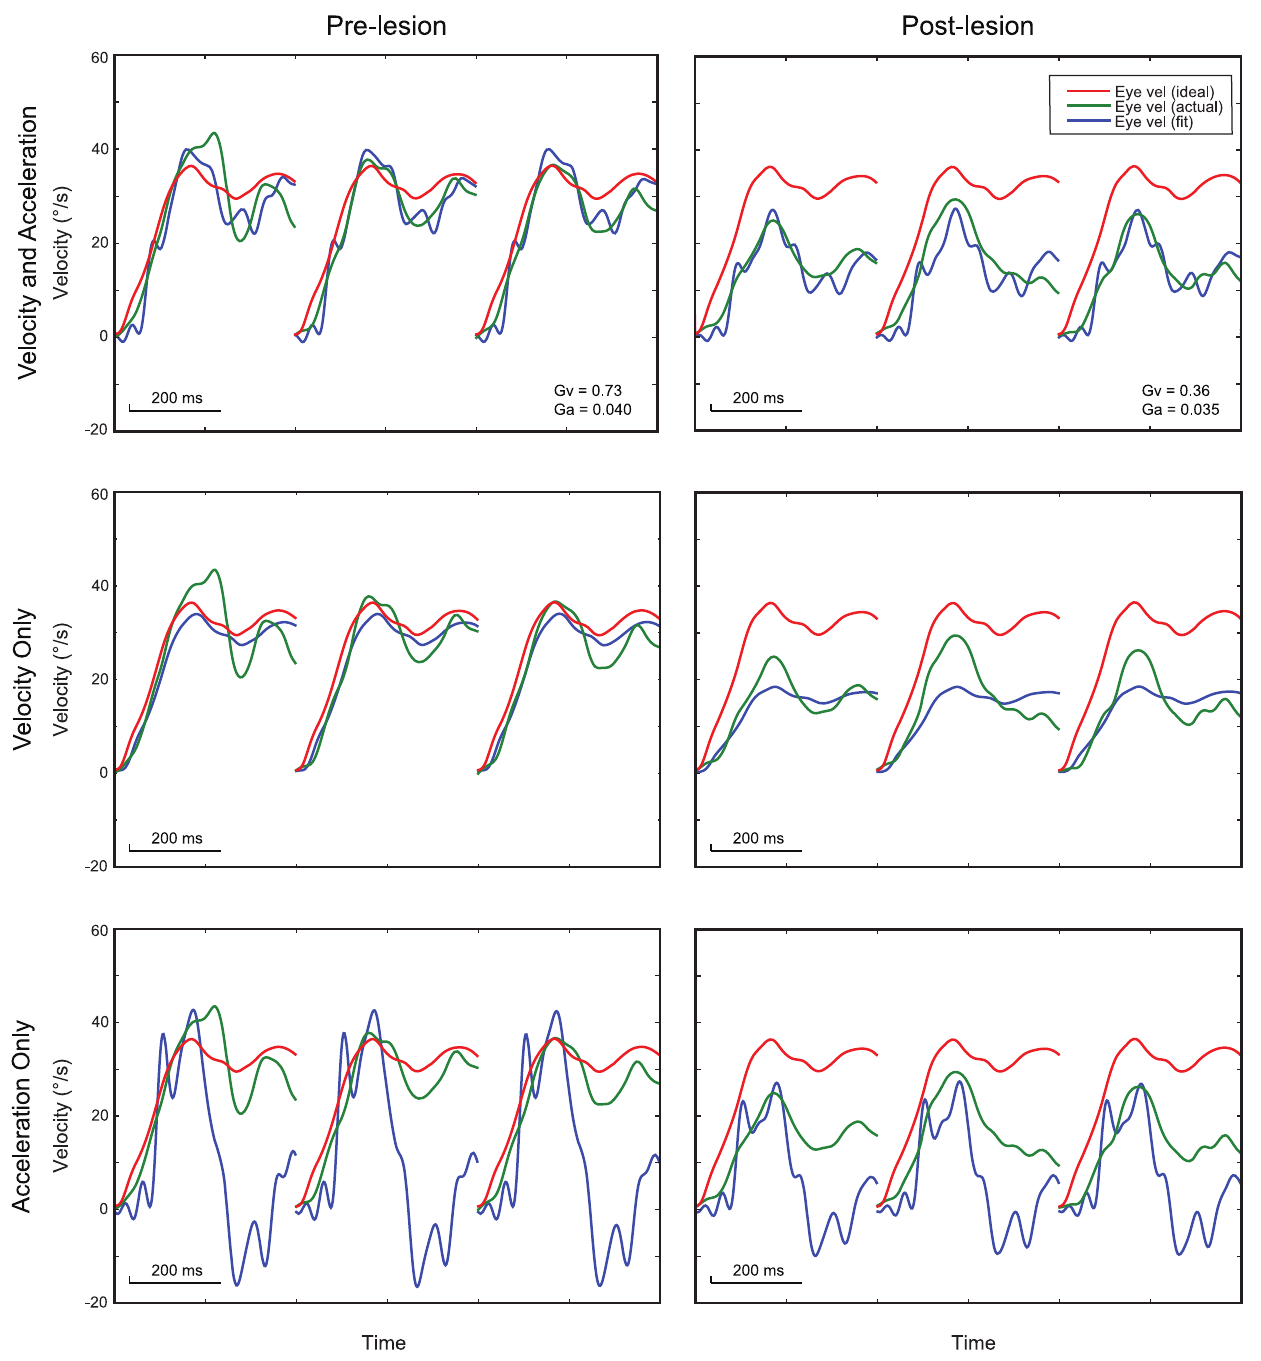
Figure 2. Example model fits for rightward translation (leftward eye velocity) in M2 (70 cm viewing distance) before and after the Nod/Uv lesion. Each panel shows three consecutive trials (first 400 ms of each) and depicts ideal horizontal eye velocity (red), measured eye velocity (green), and eye velocity calculated from the fit (blue). Note that the fit parameters were determined using data from all similar trials, not just these three. The top row shows the results of the full fit (head velocity and acceleration), the middle row the results of fitting to head velocity alone, and the bottom row the results of fitting to head acceleration alone. Only the fit that included both head velocity and acceleration modeled eye velocity well. For the post-lesion data, the velocity parameter dropped by about half, while the acceleration parameter changed little. doi:10.1371/journal.pone.0013981.g002 Our model included the ‘common’ velocity-to-position neural saccadic system include a parallel non-integrated pathway to carry integrator (NI), since the output of the model is eye position. the saccadic pulse signal from the burst neurons directly to the Without the NI, the final eccentric eye position could not be ocular motor neurons. Since the burst neurons are not thought to maintained at the end of the head movement. Models of the contribute to the VORs, we omitted the direct pathway, similar to